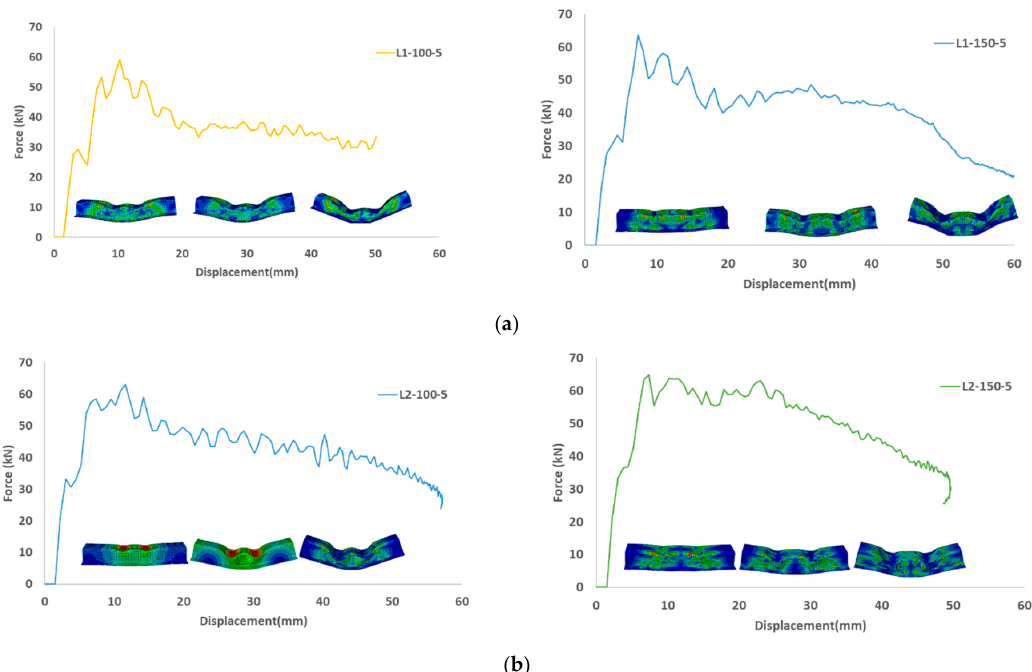
Figure 14. Load displacement diagrams at crushing speed of 5 m/s for different indenter distance of 100 mm and 150 mm ( a ) laminate configuration (0/90/0/90/0/90/0/90) (cid:2870) ( b ) laminate configura- tion (45/−45/90/0/0/90 − 45/45) (cid:2870) .